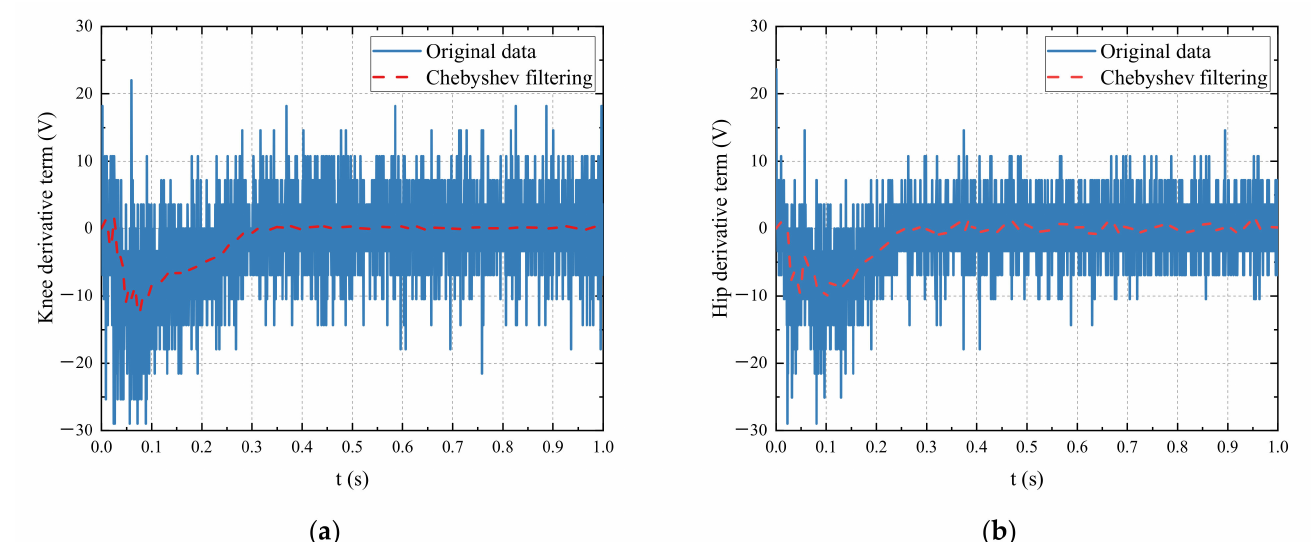
Figure 11. Derivative term before and after Chebyshev filtering algorithm: ( a ) knee PID output; ( b ) hip PID output.